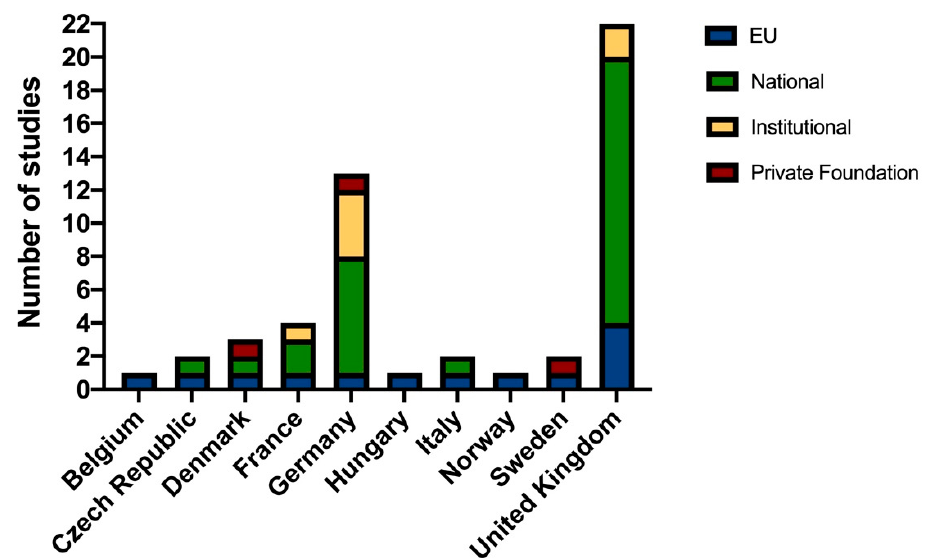
Figure 3. Financial support by country and organization. Data are presented in total numbers.